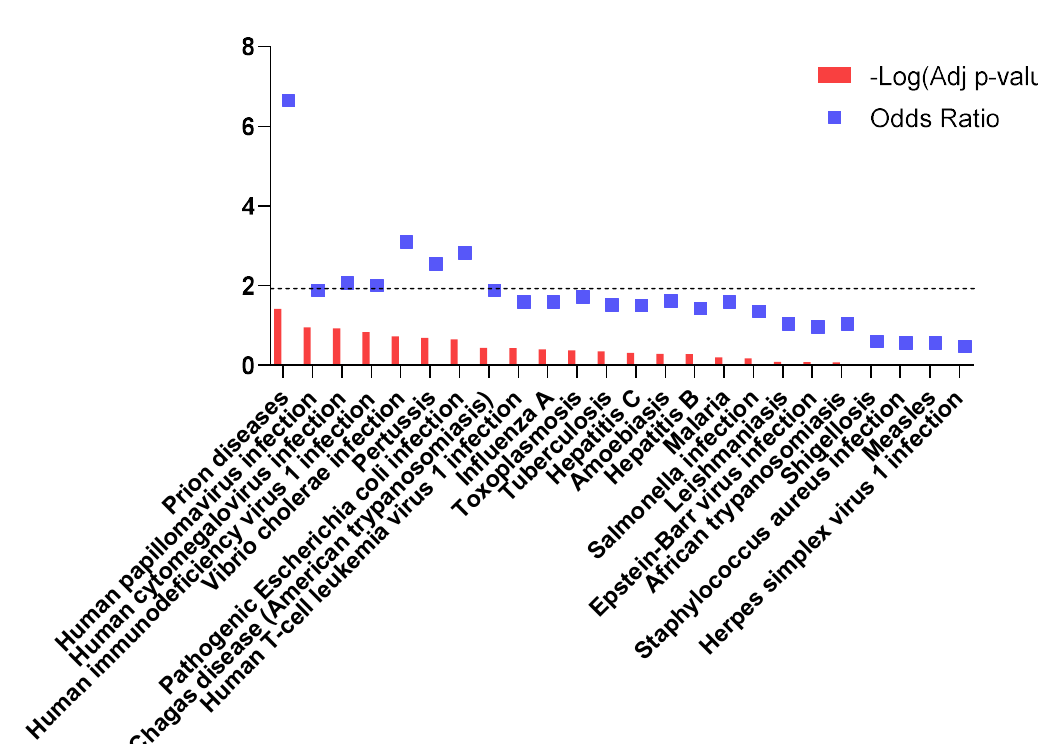
Figure 1. Infection-related pathways enriched in brain samples from ASD patients. Dotted line indicates the threshold of significance.